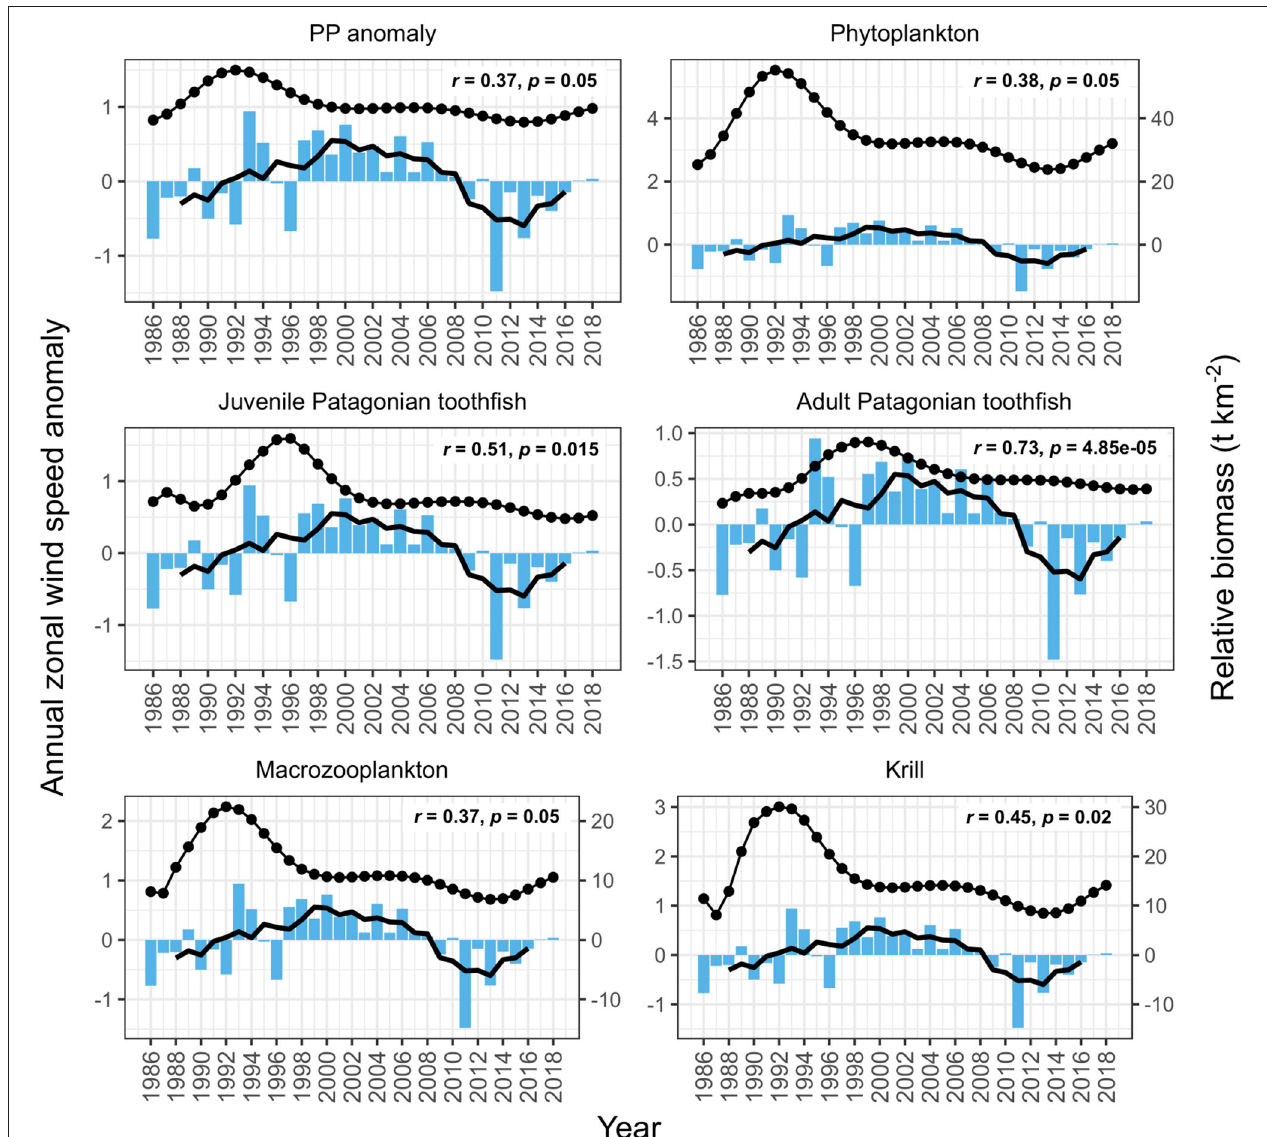
FIGURE 7 | Comparison of model output with annual zonal wind anomalies (blue bars). Black points are the estimated annual biomass values for each year of the model period and black line indicates moving average used to perform correlations (relative biomass in t km − 2 , right axis for phytoplankton, macrozooplankton and krill). Strength of correlations are shown by the r and p values in each plot, with significant correlations in